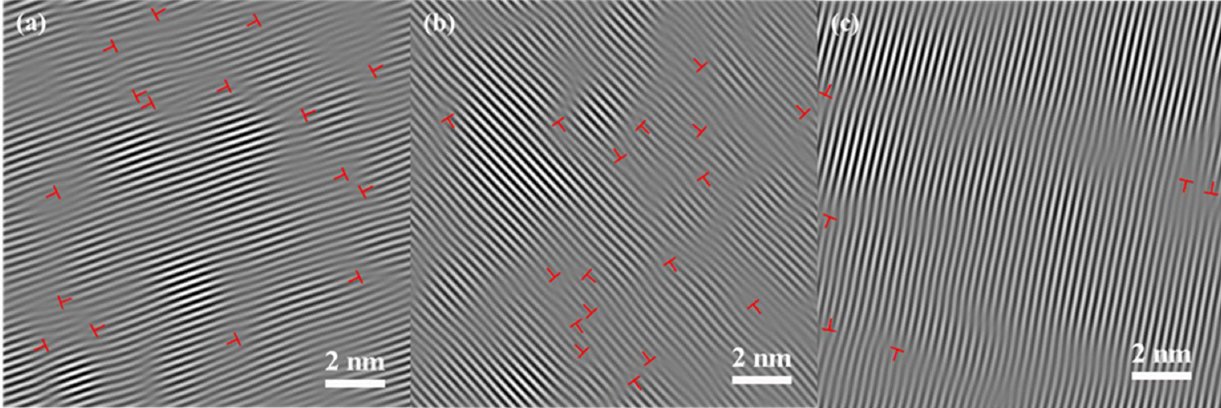
Figure 4. ( a ) ( 2(cid:4636) 10), ( b ) ( 1(cid:4636) 20), ( c ) (110) inverse Fourier transform images in the single crystal region. Figure 4. ( a ) (210), ( b ) (120), ( c ) (110) inverse Fourier transform images in the single crystal region.